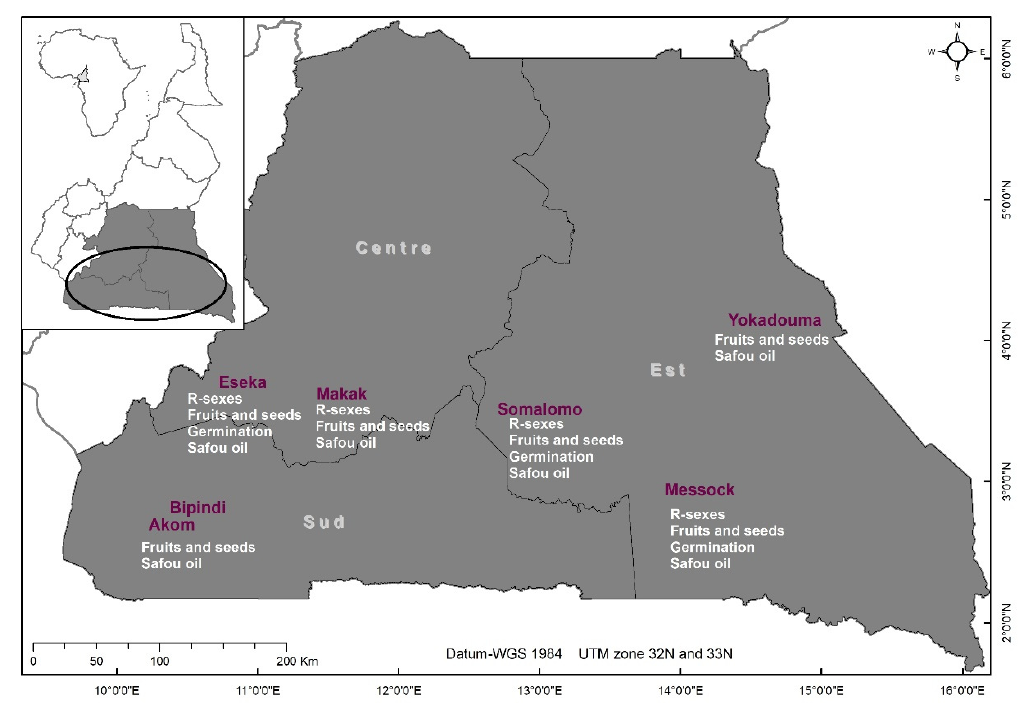
Figure 1. Study sites in the Centre, South and East regions of Cameroon and list of traits studied in each site to assess the domestication syndrome in D. edulis (R-sexes: sex distribution; fruits and seeds: fruit and seed morphometrics; germination: seed germination tests; safou oil: mesocarp lipid content and fatty acid composition). Table 2. Comparison of flower morphometric parameters in D. edulis according to the sexual type, status of individuals and